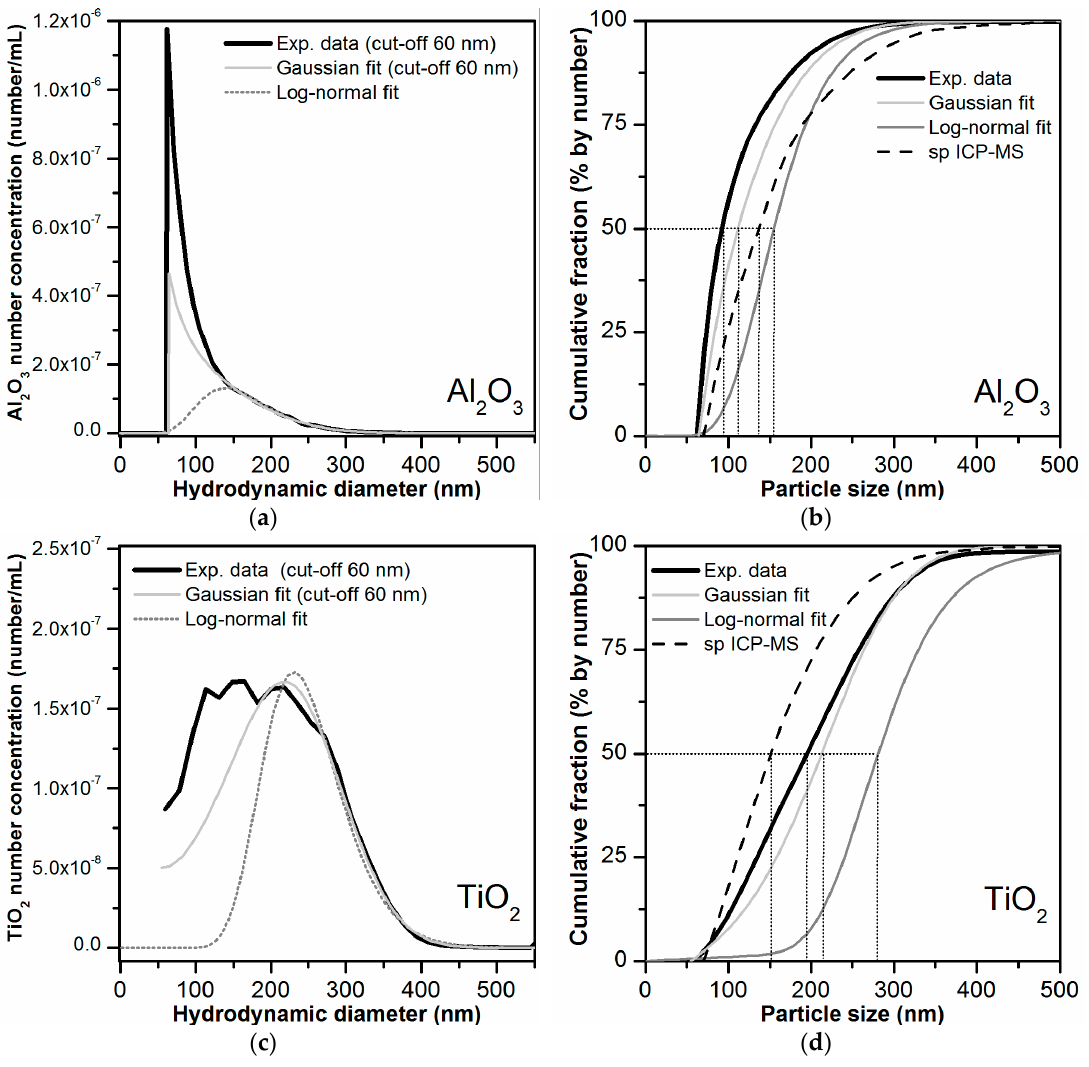
Figure 7. ( a ), ( c ) Number ‐ based PSDs obtained after mathematical conversion of the mass ‐ based AF4 ‐ ICP ‐ MS particle size data. The number ‐ based PSDs obtained after conversion of the original mass ‐ based PSDs (based on the experimental data), and of the fitted curves of the mass ‐ based PSDs (Gaussian and log ‐ normal fits) are shown for comparison. ( b ), ( d ) Corresponding cumulative PSDs obtained for experimental and the fitted data (Gaussian and log ‐ normal fits). The D50 values obtained for each distribution are highlighted by dotted lines.